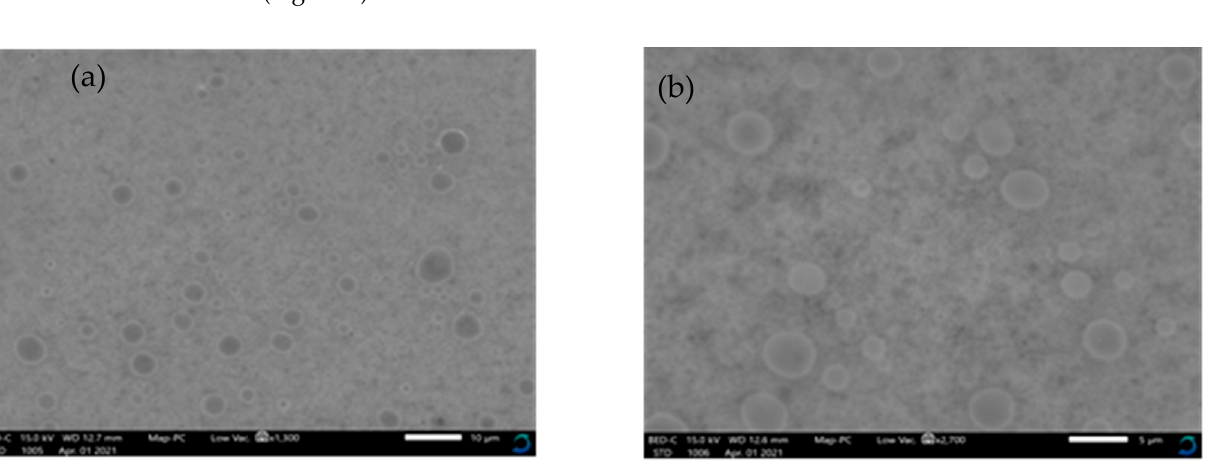
Figure 4. Scanning electron microscopy micrographs of synthesized C. papaya leaf extracts silver nanoparticles (spherical) on ( a ) 10 µm scale and on ( b ) 5 µm scale.